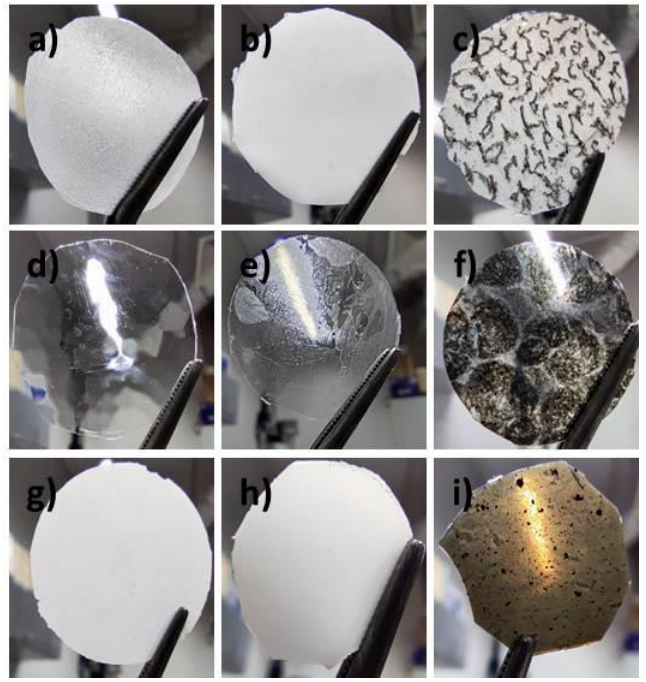
Figure 2. Created hybrid layers: PCL ( a ), PCL:5CB ( b ), PCL:SWCN ( c ); L,D-PLA ( d ), L,D-PLA:5CB ( e ), L,D-PLA:SWCN ( f ); Ecoflex ® ( g ), Ecoflex ® :5CB ( h ), Ecoflex ® :SWCN ( i ).